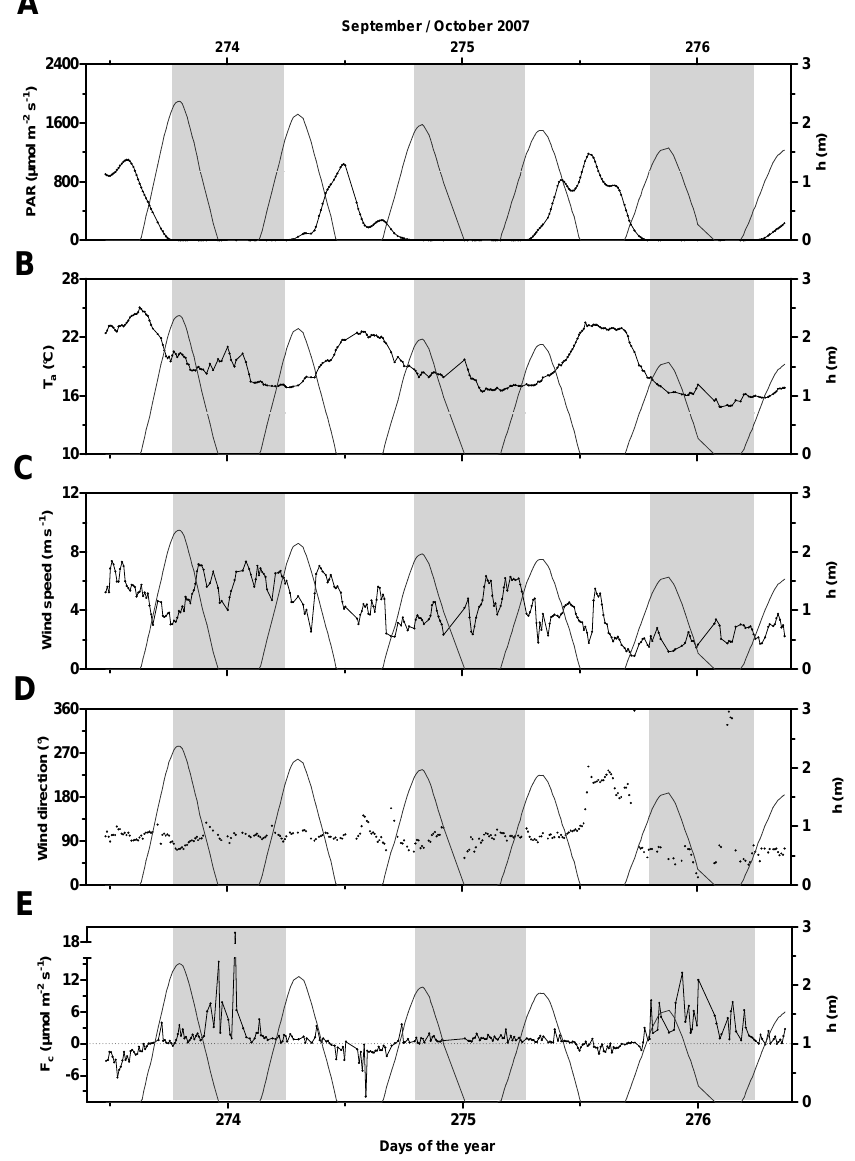
Fig. 3. Environmental parameters and carbon dioxide fluxes measured during the EC deployment in the Arcachon flat (St. 2) from 30 September at 11:35 to 3 October 2007 at 08:55 (GMT). (A) Photosynthetically active radiation (µmolm − 2 s − 1 ) and water height (m); (B) temperature of the air ( ◦ C); (C) wind speed (ms − 1 ) ; (D) wind direction ( ◦ ) and (E) carbon dioxide fluxes (µmolm − 2 s − 1 ) . Negative fluxes represent sinks of CO 2 , and positive fluxes represent sources of CO 2 to the atmosphere by convention. Day 273 squares with 30 September 2007 and grey bands represent night periods. A PAR threshold of 20µmolm − 2 s − 1 was chosen to separate day and night cases, and low tide cases correspond to zero-water heights. A specific range for F c (E) was chosen for a better visualisation of CO 2 -flux